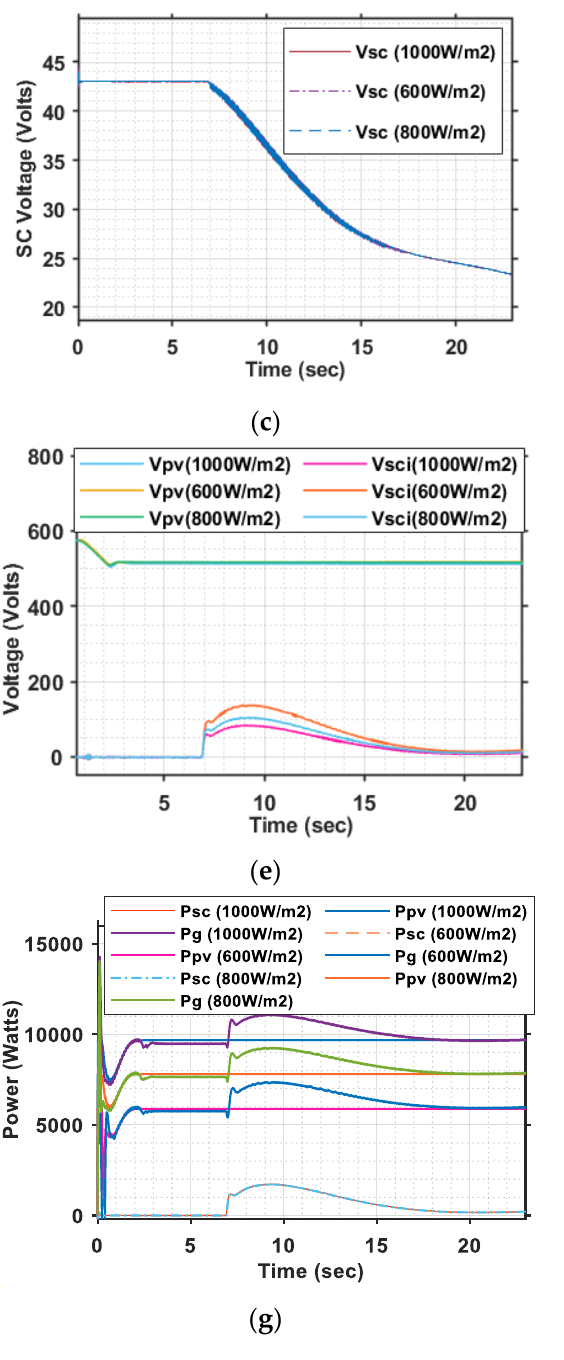
Figure 22. MATLAB simulation results for PFR based on various case studies without low-frequency fluctuation: ( a ) under-frequency event profile; ( b ) RoCoF subjected to variation in frequency; ( c ) variation in SC voltage; ( d ) voltage gain of the SC-PPS; ( e ) PV and SCI voltages; ( f ) SC power profiles corresponding to RoCoF, Droop control and the sum of both; ( g ) PV, Grid and SC powers; ( h ) SC energy profiles corresponding to RoCoF, Droop control and the sum of both.